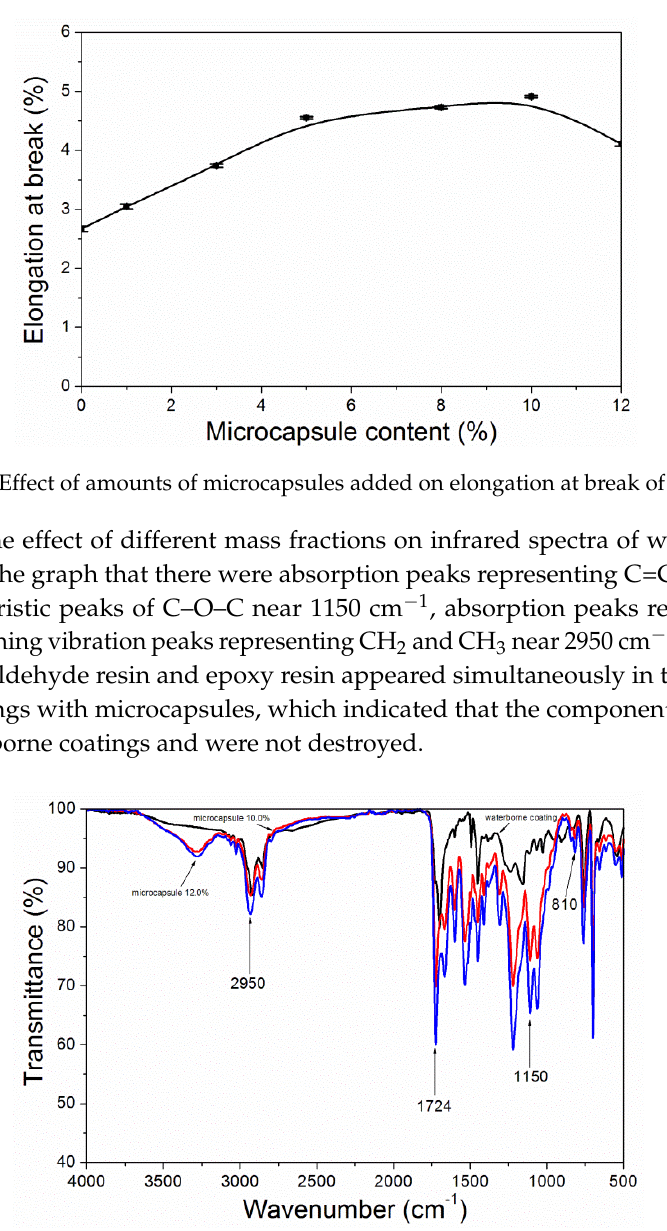
Figure 8. SEM of waterborne coatings with different contents of microcapsules: ( A ) 0; ( B ) 10.0% and ( C ) 12.0%. 3.2. Effect of Different Coating Processes 3.2.1. Analysis of Gloss of Coating Because the color difference of the coating changed little when the mass fraction of microcapsule was 10.0%, and it had low color difference and good toughness and mechanical properties, the effect of coating process on the performance of the coating was further considered by fixing the mass fraction of microcapsule at 10.0%. The influence of the coating process on the gloss of coating is shown in Figures 9–11. It can be seen from the figure that the gloss of the coatings with microcapsules added to primer was higher than that with microcapsules added to topcoat under the same coating process at different incident angles of 20 , 60 and 85 . When the microcapsules were added to the primer and the layer number of topcoat was two, the gloss of coating increased with the increase of the layer number of primer. When the microcapsules were added to the primer and the layer number of topcoat was three, the gloss of coating decreased with the increase of the layer